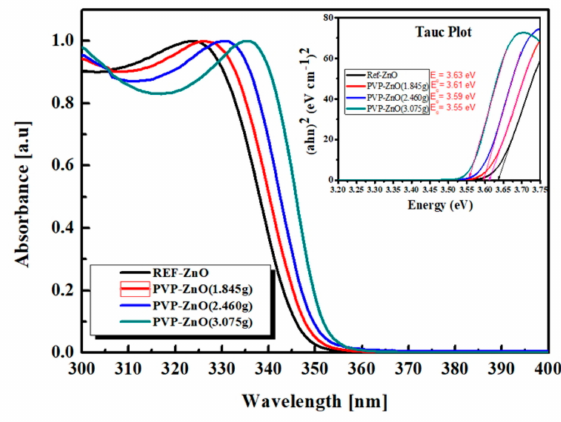
Figure 3. UV-visible absorption spectra of PVP-ZnO NPs (1.845 g, 2.460 g, 3.075 g) and Ref-ZnO NPs. Insert showing bandgap energy using Tauc plot from UV-visible absorption